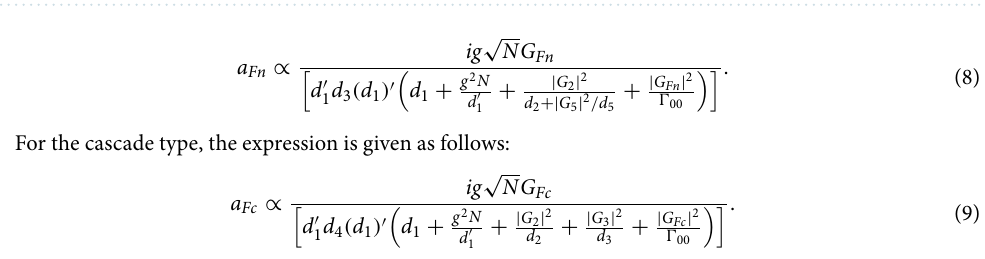
Figure 5. ( a1 )–( a3 ) The high-order modes intensity transmission coefficients of FWM signal of cascaded 0 MHz . The solid curves represent the transmission peaks with different parameters. The dashed type at (cid:31) ac = curves are the transmission spectra of empty cavities. ( a1 ) With � 3 /Ŵ 20 50 . ( b1 )–( b3 ), The details of FWM intensity transmission coefficients in the narrow regions of With � 3 /Ŵ 20 = high-order modes corresponding to ( a1 )–( a3 ). ( c1 )–( c3 ) The avoided-crossing plots with both scanning (cid:31) 1 and (cid:31) ac corresponding to ( a1 )–( a3